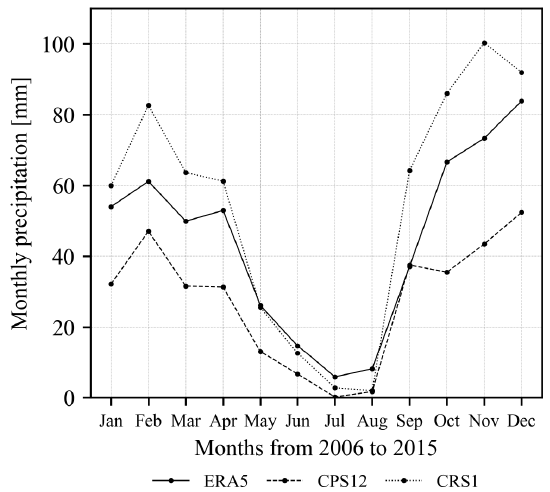
Figure 4. Monthly precipitation [mm] over Madeira Island in the ERA5 reanalysis, CPS12 and CRS1 from 2006 to 2015. For each dataset, the grid cells whose centres are located within ellipse e 1 in Fig. 2a were used to calculate the spatially averaged monthly pre- cipitation. That is, 1 grid cell ( ∼ 961km 2 ) in the ERA5 reanalysis, 6 grid cells ( ∼ 864km 2 ) in CPS12 and 666 grid cells ( ∼ 800km 2 ) in CRS1 were